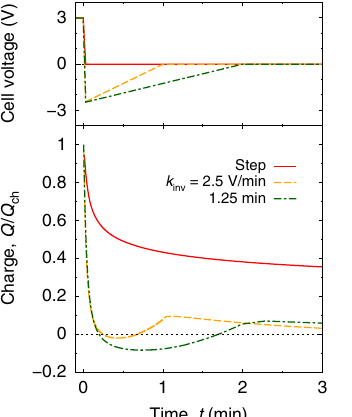
Fig. 7 Accelerating discharging by voltage inversion for novolac-derived carbons. Cell voltage as a function of time for step-voltage discharging (red line) and for two voltage-inversion sweeps given by eq. (10) with U = − 2.5 V (top plot). The bottom plot shows the accumulated charge, inv expressed in terms of the initial charge Q ch , after application of the discharging protocols from the top plot. The supercapacitor was initially charged with a step voltage for about 1 h at cell voltage U ch = 3 V. For discharging at an elevated temperature and with a lower inversion voltage see Fig.